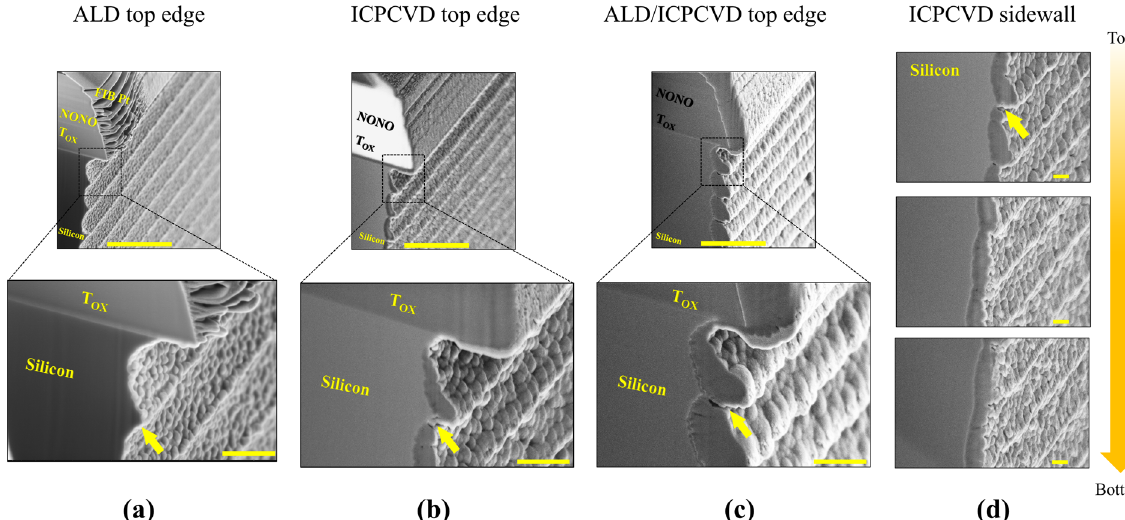
Fig. 4 FIB-SEM cross-section views of sidewall coverage after deposition. Yellow arrows indicate the protection fi lms and gaps in coverage. a Top edge of an ALD-protected device shows conformal and uniform coverage without gaps. The top and bottom images ’ scale bars are 2 µm and 500 nm, respectively, for ( a – c ). b Top edge of an ICPCVD-protected device, in which low conformality is noted, and, in particular, gaps in coverage. c Top edge of an ALD/ICPCVD-protected device, in which a relatively uneven (bulging) fi lm morphology and gaps in coverage are noted. d ICPCVD-protected sidewall, at various heights, revealing a noticeable gap in coverage at the top and more uniform coverage toward the bottom. The scale bars are 200 nm. T OX = thermal